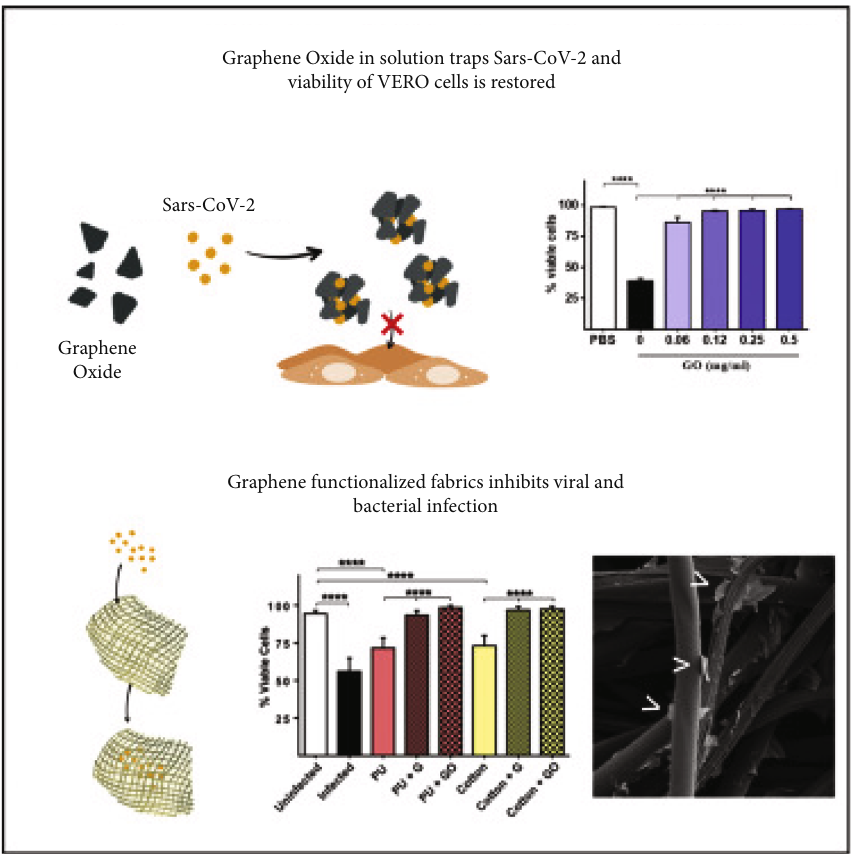
Figure 8: Schematic diagram to trap SARS-CoV-2 using graphene oxide and functionalized fabrics for inhibition of viral and bacterial infection